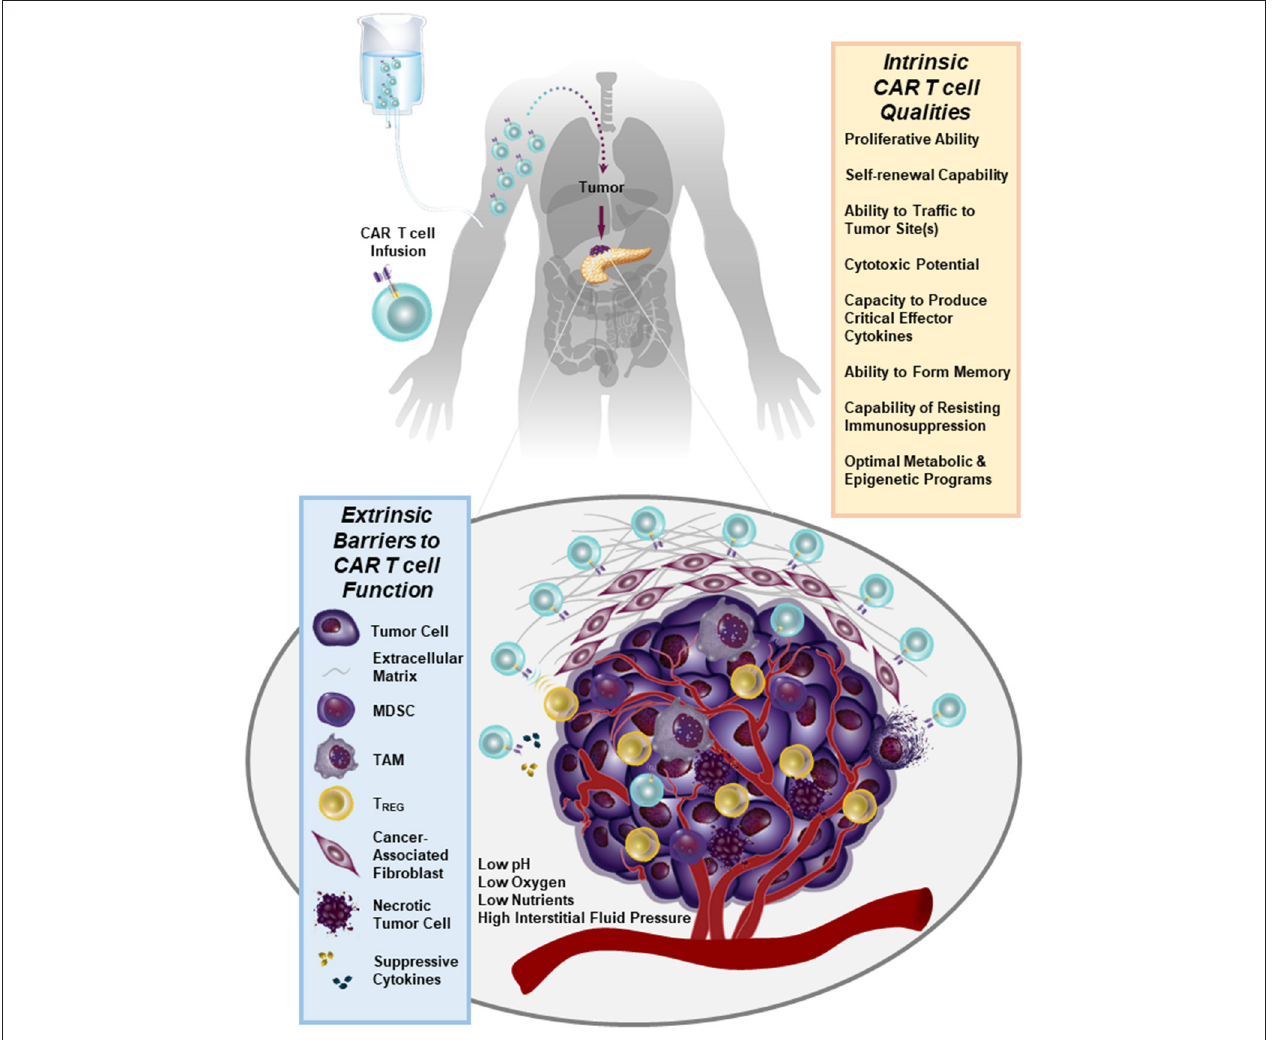
FIGURE 1 | Numerous immunosuppressive barriers present in the solid tumor microenvironment that can hamper the efficacy of CAR T cell therapy are schematically depicted. Several intrinsic qualities of CAR T cells that may impact the anti-tumor potency of these lymphocytes are also